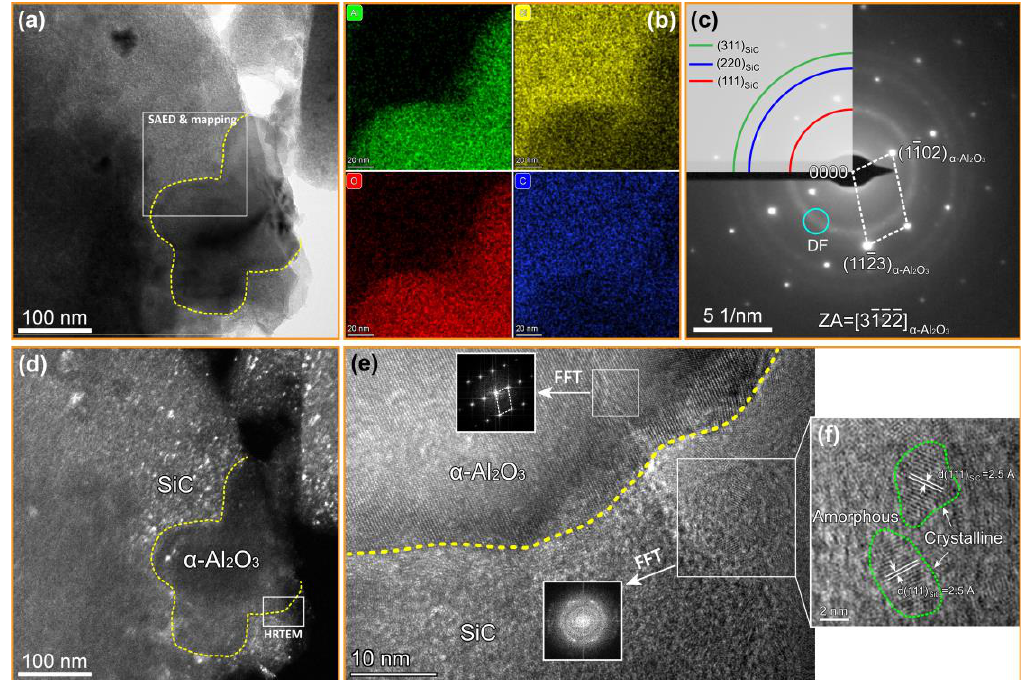
Figure 4. ( a ) Bright field TEM image of the SiC matrix with α -Al 2 O 3 nanoparticles of the C f /SiC-Al 2 O 3 composite; ( b ) elemental mapping images of Al, Si, O and C of boxed area in ( a ); ( c ) SAED pattern of boxed area in ( a ); ( d ) dark-field TEM image of ( a ), obtained using the circled reflection in ( c ); ( e ) HRTEM images of the framed region in ( d ); and ( f ) enlarged view of the boxed SiC area in ( d ).